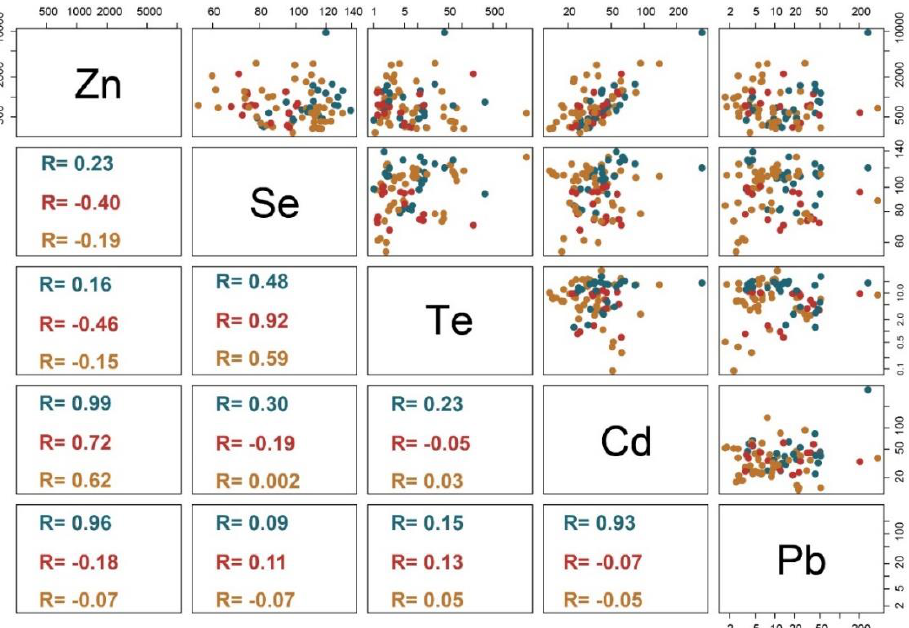
Figure 9. A fragment of Pearson correlation matrix and corresponding binary plots for chalcopyrite of the three different ore types of the Oktyabrsk deposit. The full correlation matrix is not provided due to its size. However, other elements show the same feature that the three different ore types cannot be distinguished from each other by using binary plots, though some elements show stronger correlations for chalcopyrite of disseminated ore (e.g., Zn-Cd, Zn-Pb) when compared to chalcopyrite of the other ore types. Colors in the caption (red, green, yellow) correspond to symbols of the same colors.